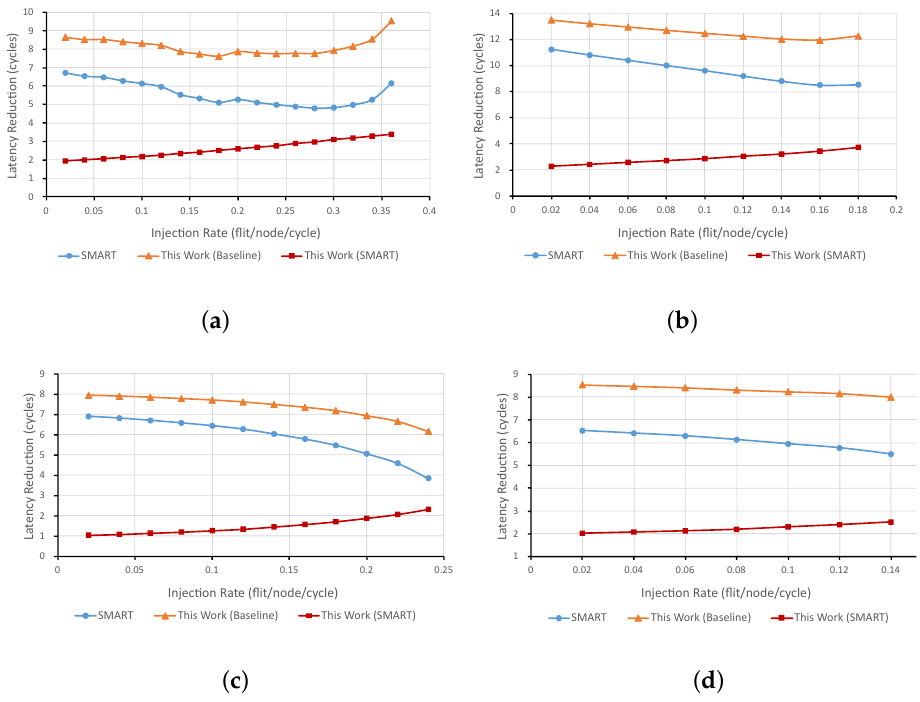
Figure 10. Latency Reduction. ( a ) Uniform Random, ( b ) Bit Complement, ( c ) Tornado, and ( d )